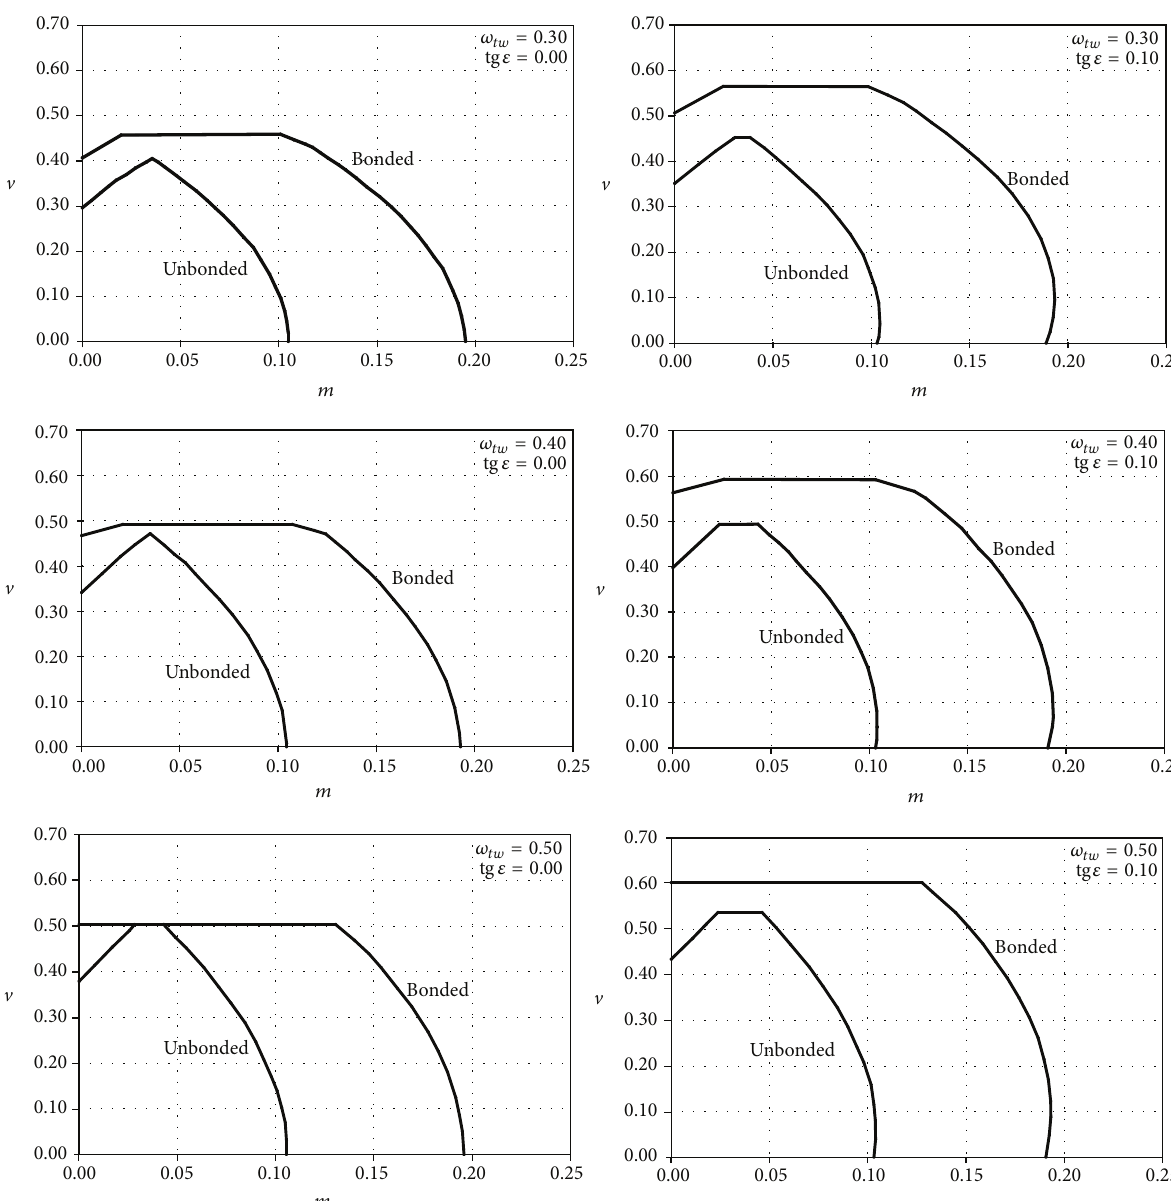
Figure 5: M - V interaction domains for different values of reinforcement ratios and prestressing tendon slope.